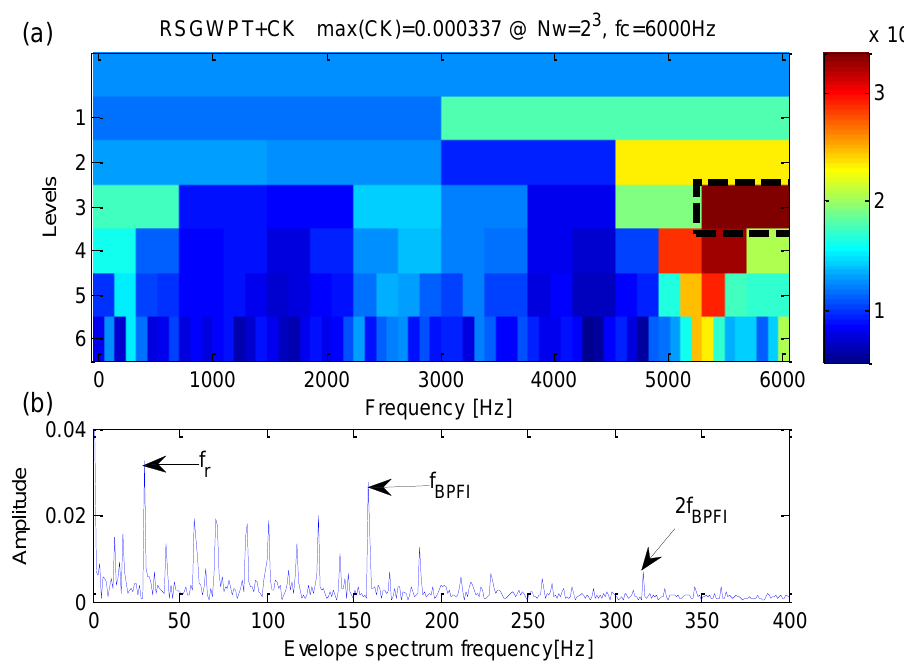
Figure 14. ( a ) The improved kurtogram of data X171_FE; ( b ) the envelope spectrum of the frequency band with the maximum correlated